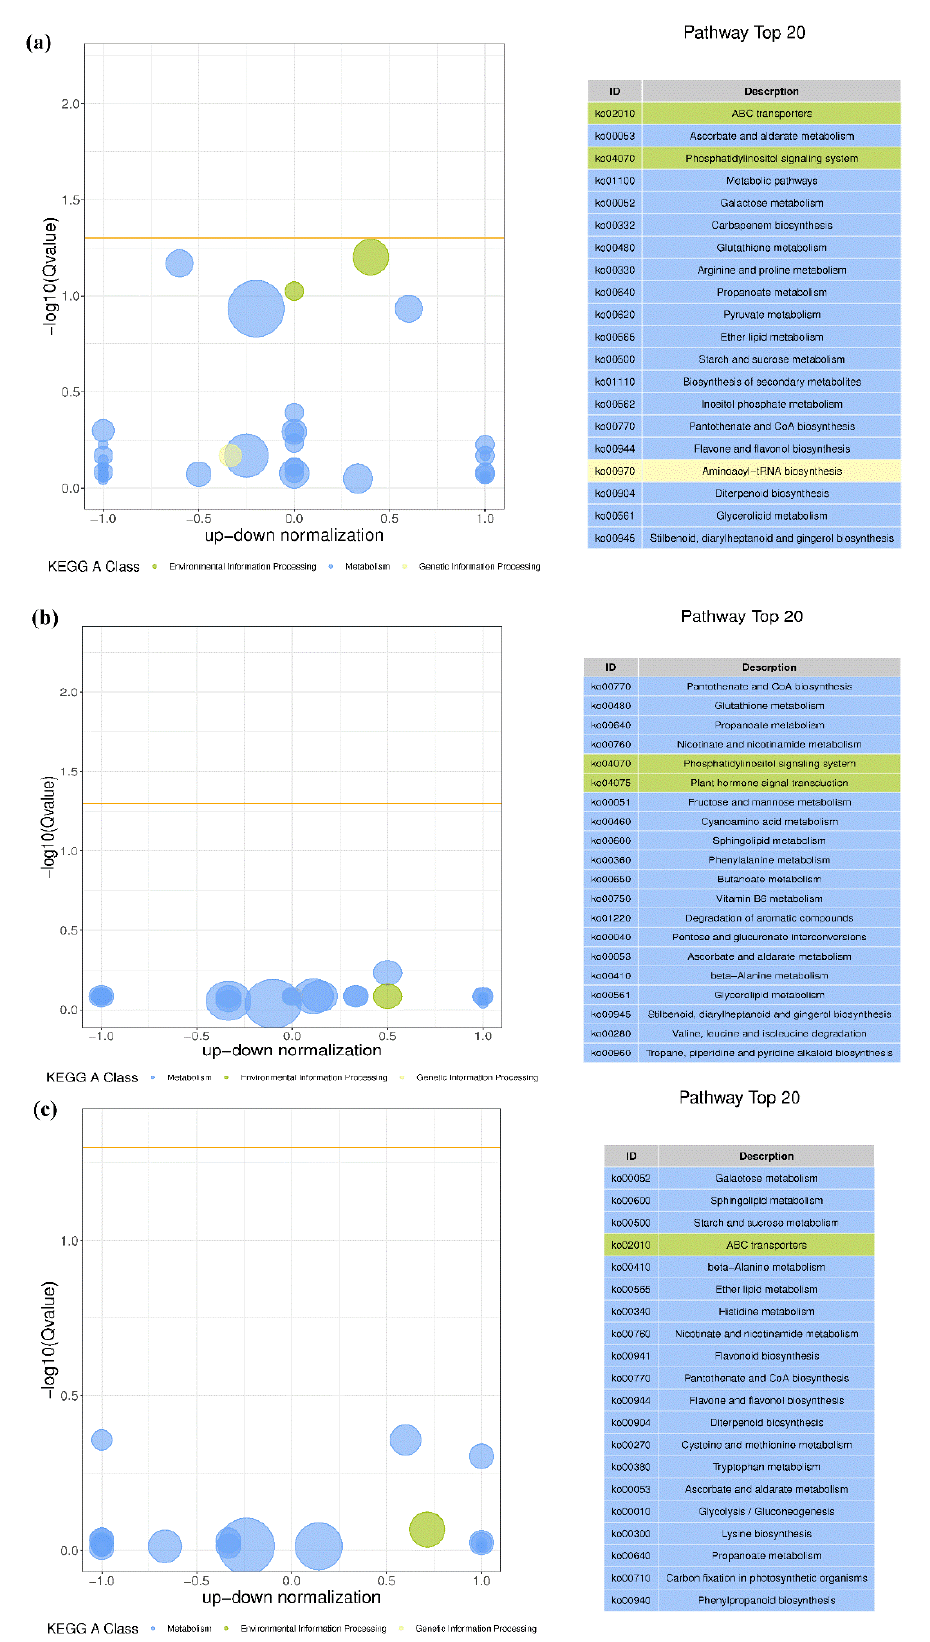
Figure 9. Bubble plot of KEGG enrichment differences. ( a ) Group A vs. Group K; ( b ) Group A vs. Group G; ( c ) Group G vs. Group K.